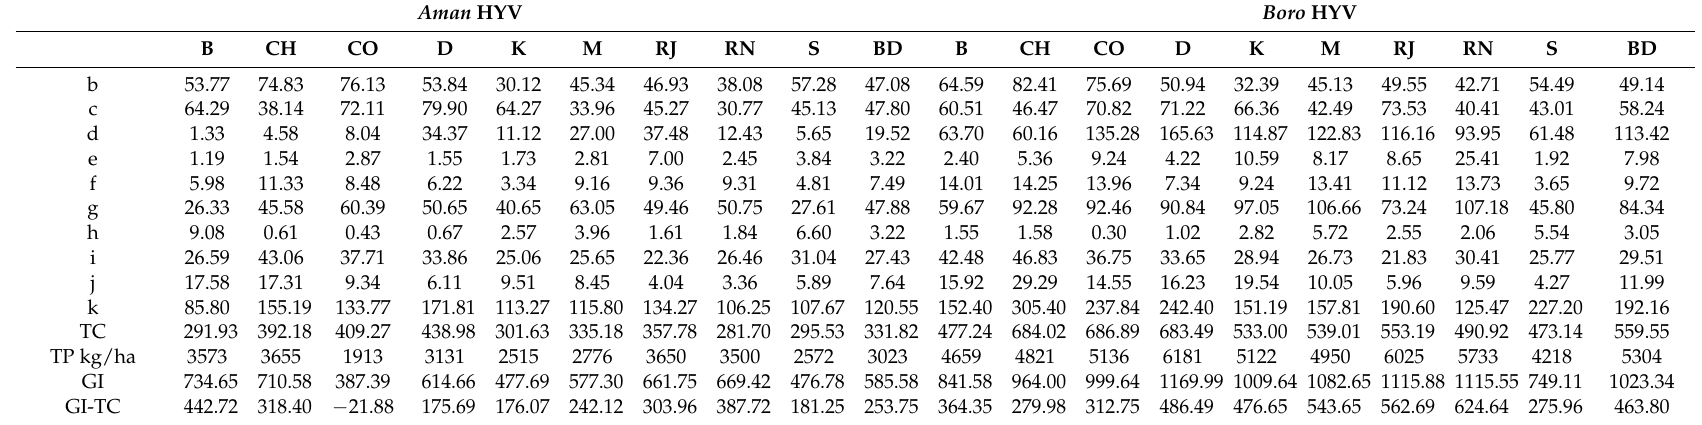
Table A3. Costs and income (US$/ha) associated with aman and boro HYV rice production, by region. Aman HYV Boro